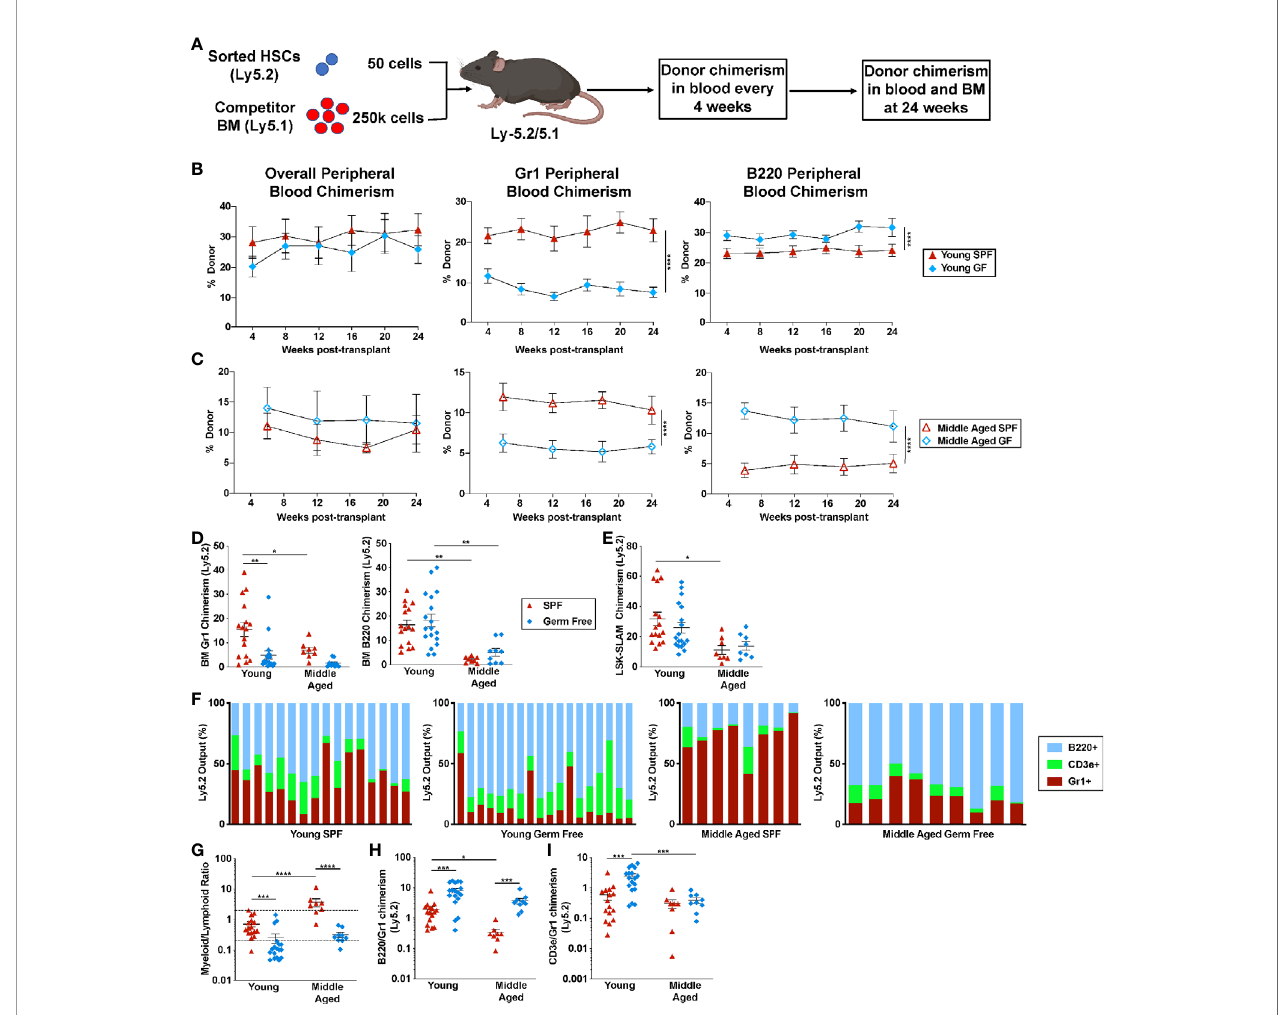
FIGURE 5 | Microbiota signals suppress the lymphoid potential of aged HSCs. (A) Experimental schema. Created with BioRender.com. (B) Fifty sorted LSK-SLAM cells from the indicated donors were transplanted into irradiated wildtype SPF mice and donor peripheral blood chimerism assessed every four to six weeks. Shown is donor (Ly5.2) contribution to total leukocytes, granulocytes and B cells in recipients of transplanted young HSCs (B) or aged HSCs (C) . (D, E) Donor chimerism in bone marrow Gr-1 + cells and B220 + cells (D) or LSK-SLAM cells (E) harvested 24 weeks after transplantation. (F) Shown is the contribution of each lineage to the total donor cell pool; each bar indicates an individual recipient. (G) Quotient of donor bone marrow myeloid cells (Gr1 + ) cells to lymphoid (CD3e + plus B220 + ) cells for each recipient. Myeloid-biased mice had a ratio > 2, lineage balanced were between 0.25 and 2, and lymphoid-biased mice had a ratio <0.25. (H, I) Ratio of donor bone marrow B220 + to Gr1 + chimerism (H) or donor bone marrow CD3e + to Gr1 + chimerism ( I ). Data represent the mean ± SEM. *P < 0.05, **P < 0.01, ***P < 0.001, and ****P < 0.0001 by one-way ANOVA with alpha = 0.05 and Sidak ’ s multiple comparisons